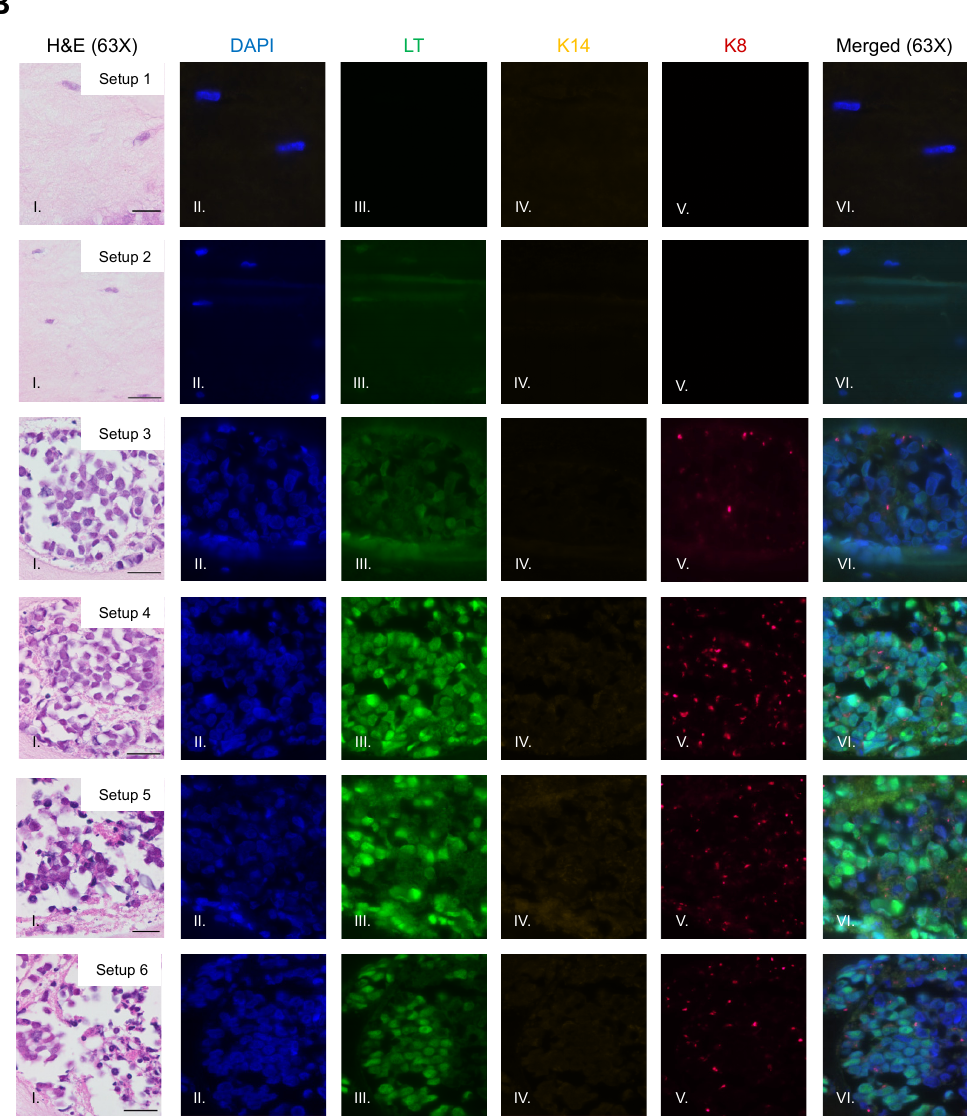
Figure 3. Identification of MCPyV+ MCC cells within raft structures. ( A ) Tissue sections from all raft setups were subjected to immunofluorescence analysis for LT antigen expression. DAPI counterstain was used to identify cell nuclei (blue, Column II), LT antigen was detected using the CM2B4 antibody (green, Column III), and K14 staining was used as an epithelial marker (yellow, Column IV). Corresponding H&E images are shown in Column I. All images are shown at 20 × magnification. Scale bars = 100 µ M. ( B ) High magnification (63 × ) of representative MCC-lesions that developed in rafts and IF biomarker analysis. Panel I—H&E, Panel II—DAPI (blue), Panel III—LT antigen (green), Panel IV—epithelial marker cytokeratin 14 (yellow), Panel V—cytokeratin 8 (pink). Merged IF images are shown in Panel VI. For rafts that do not develop these MCC lesions (Setup 1 and 2), representative images of the dermal layer are shown. Scale bars = 20 µ M. Note in Setup 3 (panel III) LT staining was dimmer than in the MCC-like lesions that arose under other setups (4–6). We believe this is an artifact of the position of the MCC-like lesion under setup 3 toward the edge of the raft, where we often see a dimmer fluorescence